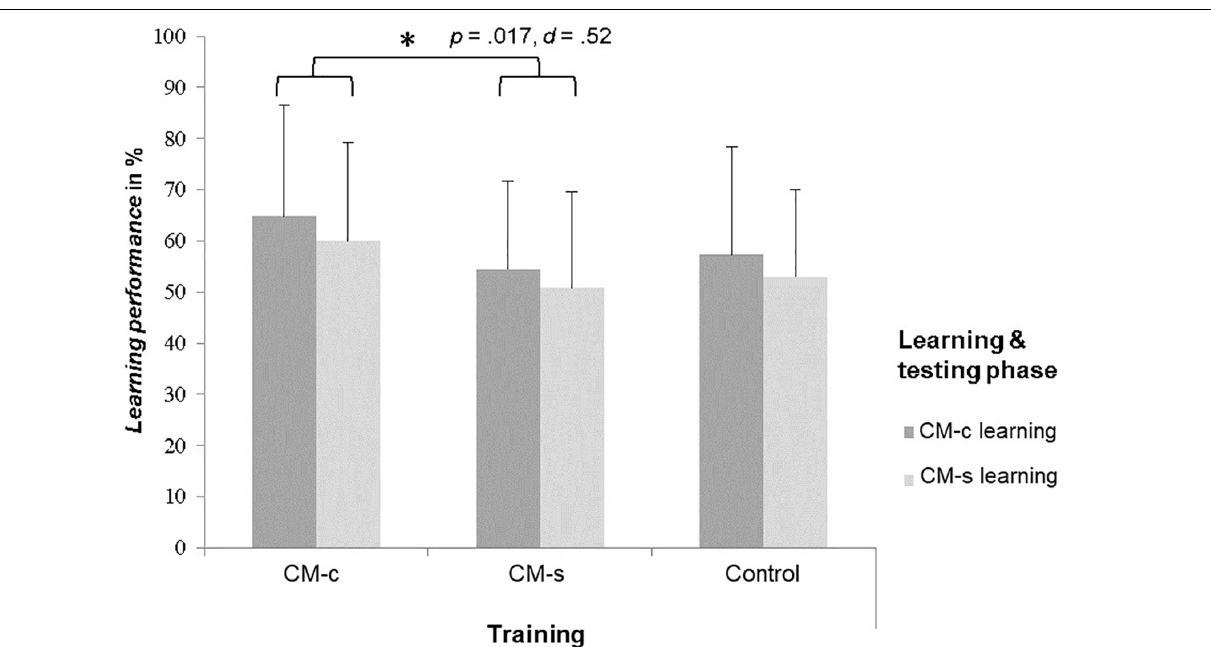
the control training (15.77 ± 14.09; p = 0.004, d = 0.95)